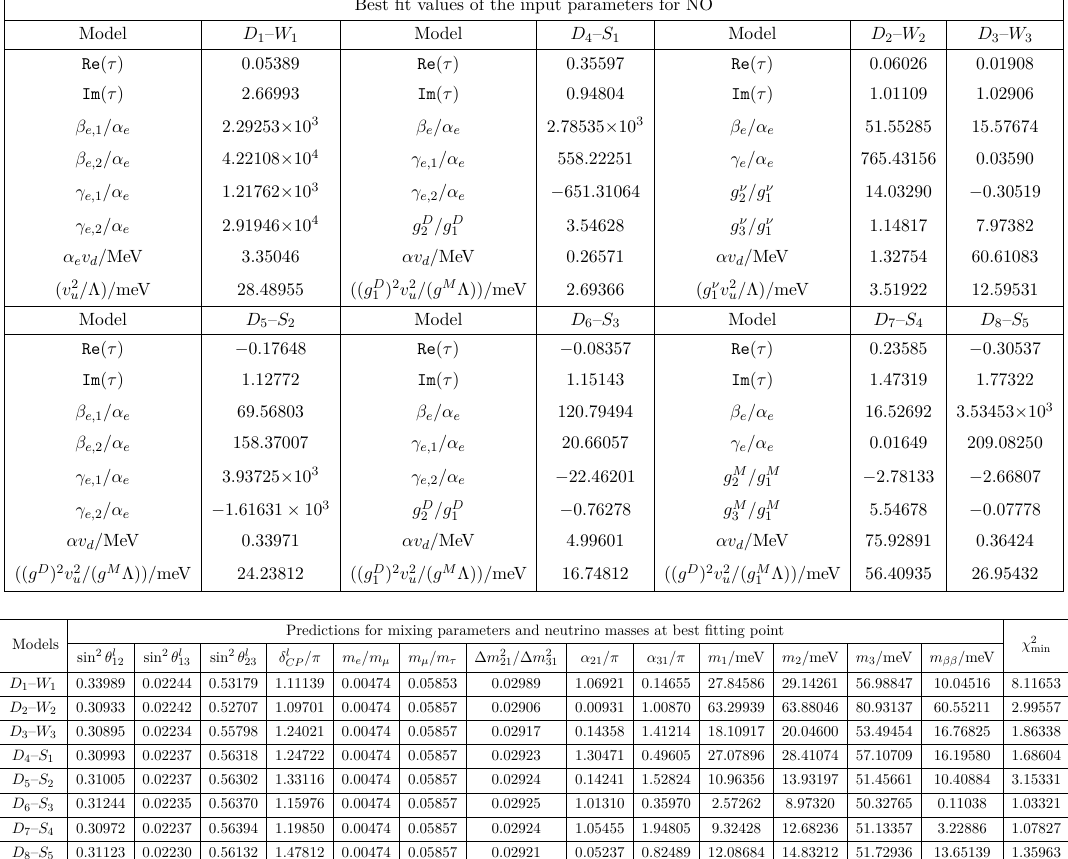
triplet and the right-handed changed leptons E c 4 Best fit values of the input parameters for NO